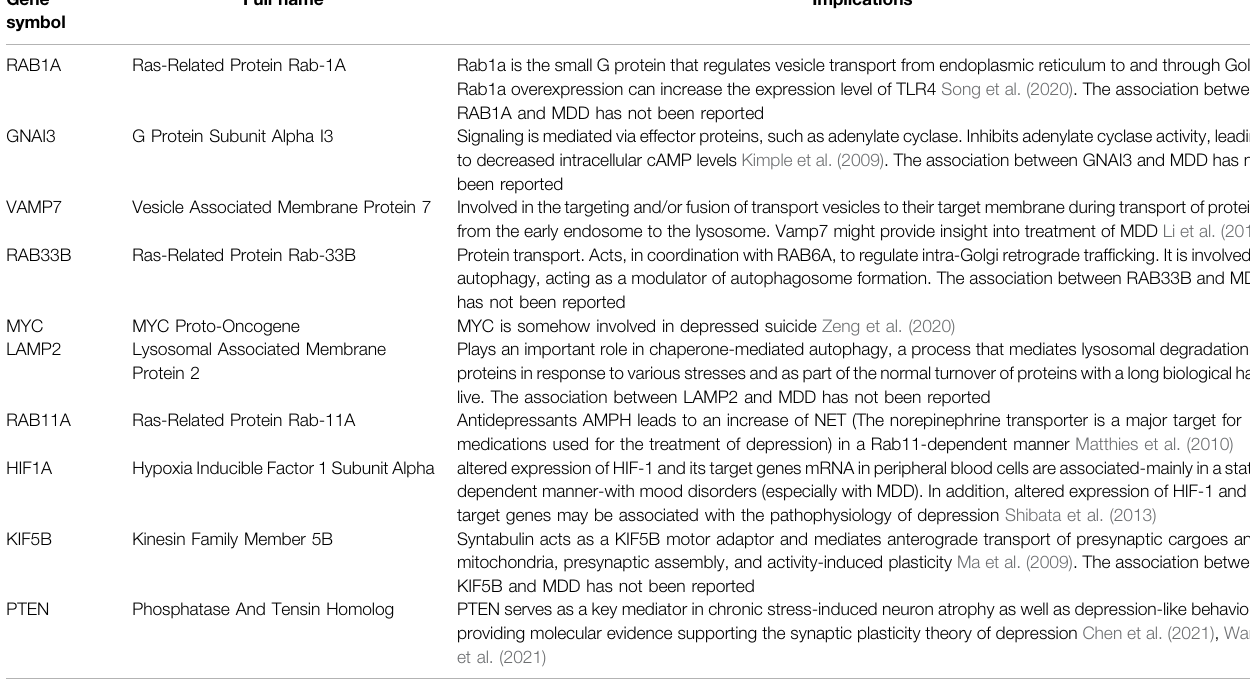
TABLE 2 | Implications of the 10 key